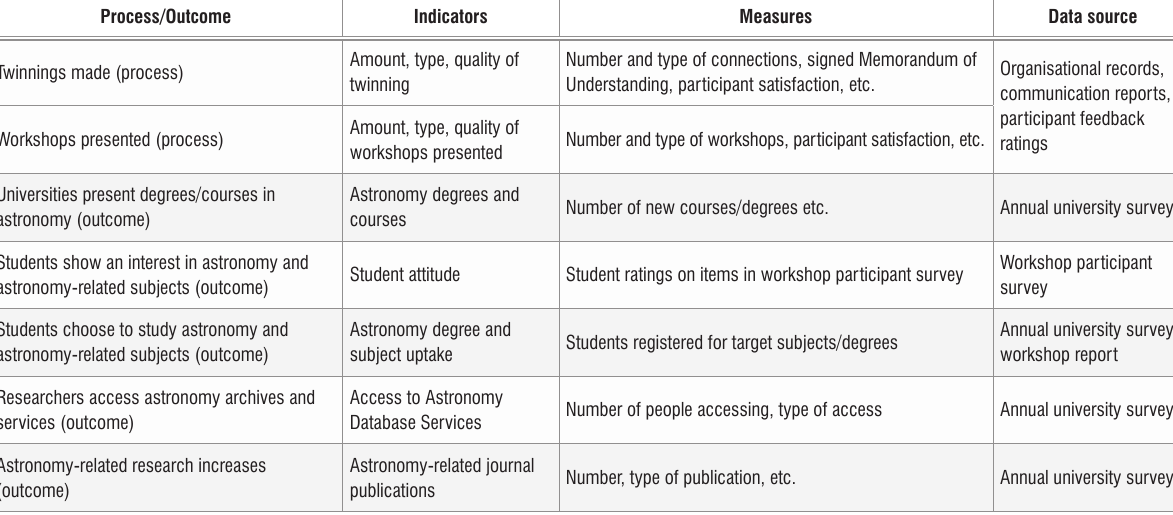
Organisational records, communication reports, participant feedback